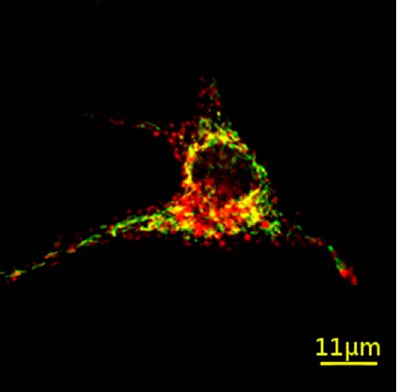
Figure 8. Fluorescence image obtained by confocal microscopy of U87 MG cell loaded with Au@DTDTPA-Cy5 nanoparticles (red) in the presence of MitoTracker Green (green). Yellow reflects the colocalization of fluorescent gold nanoparticles and mitochondria.